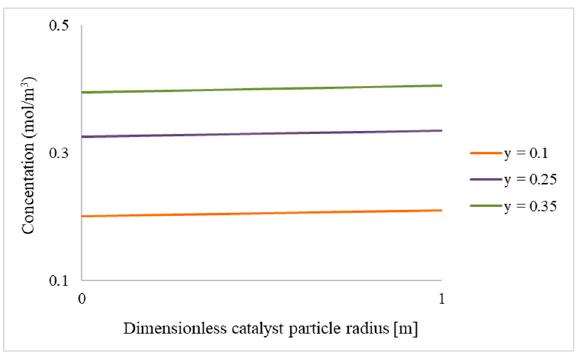
Figure 8. Concentration of formic acid within the catalyst particles at x = 1.25 cm, generated from modelling. Reaction conditions: temperature = 30 °C; pressure = 1 bar; inlet flow = 0.05 mL/min; 0.1 g catalyst of 5 wt.% Pd on Carbon.